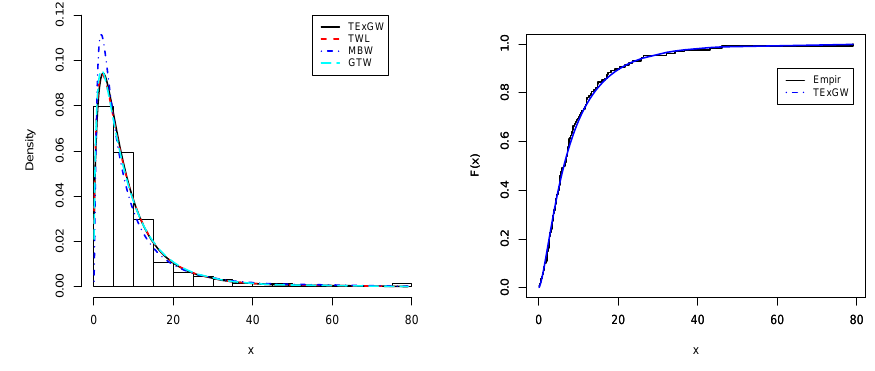
Fig. 6. The fitted pdfs (left panel) and the TExGW fitted cdf (right panel) for data set II